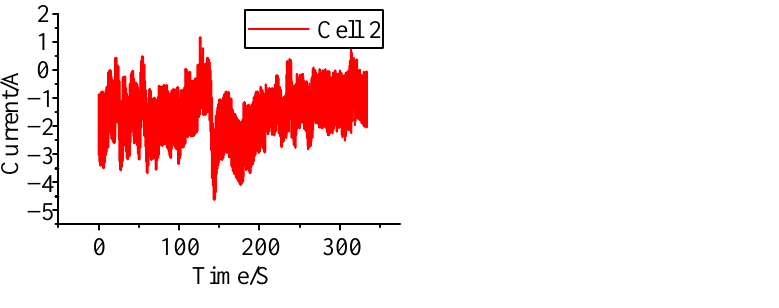
Figure 16. Lithium battery SOC change chart. (Adjacent equalisation circuits and fuzzy control strategies) 5.4. Comparison with the Control Method Based on SOC Difference The control approach based on SOC difference was also simulated and examined in this article. Figure 17 shows the current flowing via the battery 2. Although the maximum current was reduced, the battery current will continue to exceed the limit. Figure 18 shows that when a battery is fully charged, the group of batteries does not approach equilibrium. Figure 17. Lithium battery current change diagram. (Adjacent equalisation circuits and SOC dif- ference-based equalisation strategies)